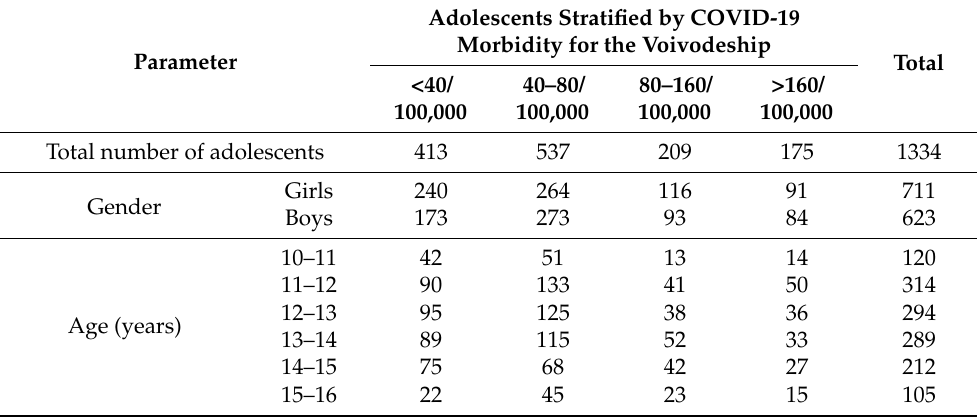
Table 1. The general characteristics of the studied group of Polish adolescents within the Diet and Activity of Youth during COVID-19 (DAY-19)